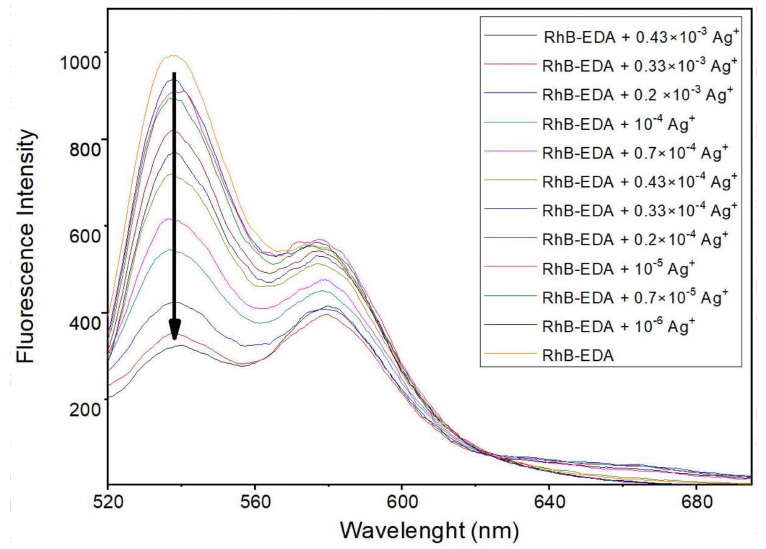
Figure 8. Fluorescence spectra of 100 µ M RHB-EDA probe in the presence of various concentrations of Ag + ions at pH 7 (DMSO:MOPS:H 2 O = 3:14:13) ( λ ex / λ em = 500/538